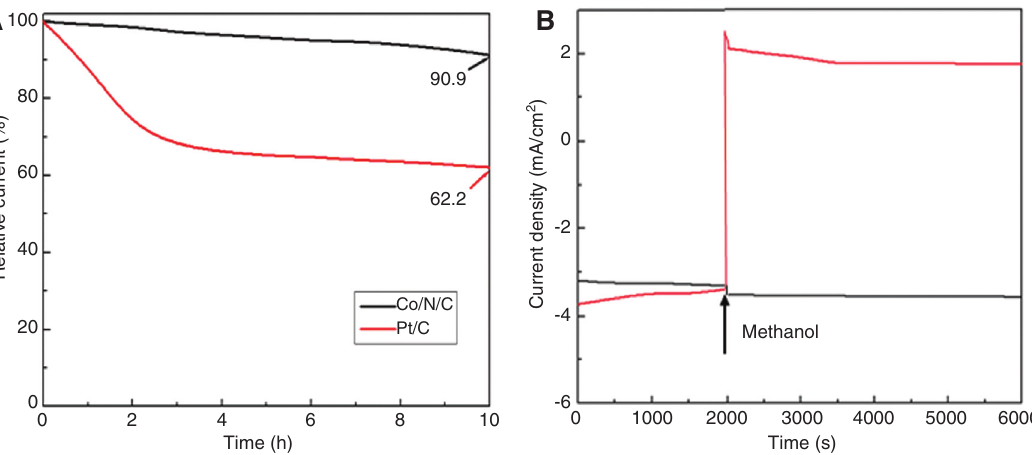
Figure 6: (A) The current-time (i-t) curves of Co/N/C and 20% Pt/C catalysts at -0.4 V [vs. saturated calomel electrode (SCE)] in an O -saturated 0.1 m KOH solution for 10 h. (B) Chronoamperometric responses of Co/N/C and 20% Pt/C catalysts at -0.4 V in an O 2 0.1 m KOH solution without methanol (0–2000 s) and with adding methanol (2000–6000 s). The arrow represents the addition of